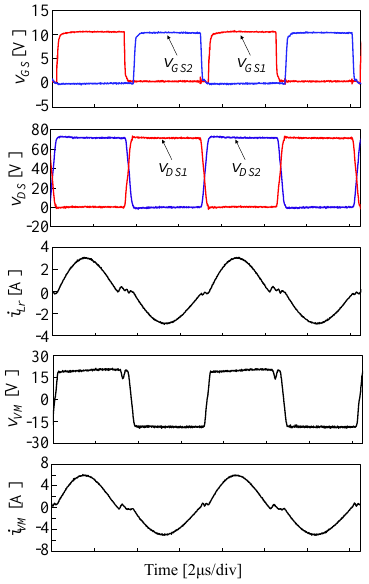
Figure 13. Measured key operation waveforms at I Rvar = 1.5 A with tap X selected.